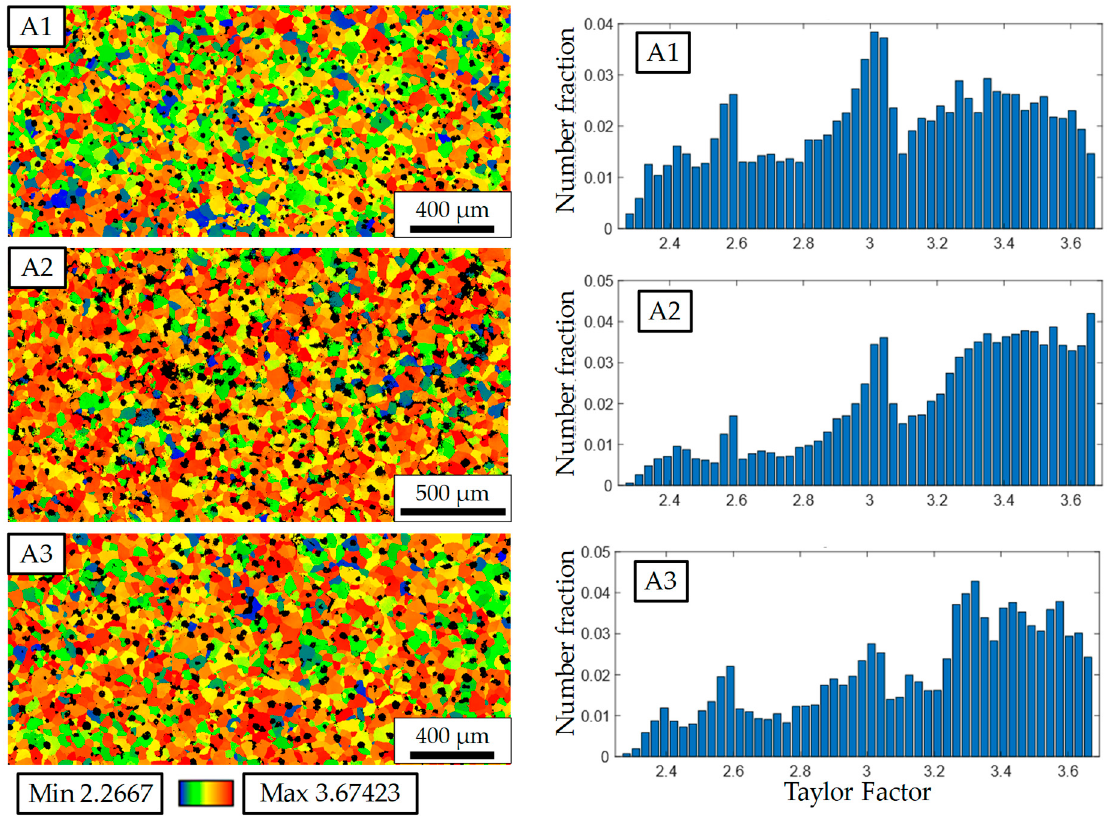
Figure 9. Taylor factor maps of alloys A1–A3, loading out of paper plane.